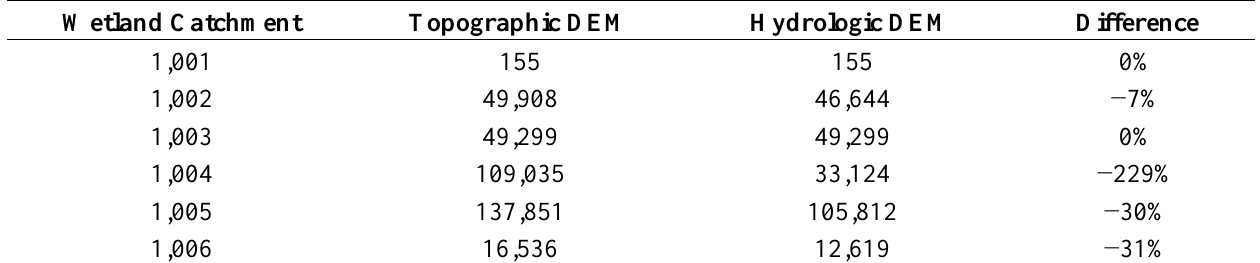
Table 3. Depression Storage Volumes simulated using LiDAR-derived digital elevation models (DEM) with (Hydrologic DEM) or without (Topographic DEM) culvert information incorporated (unit: m 3